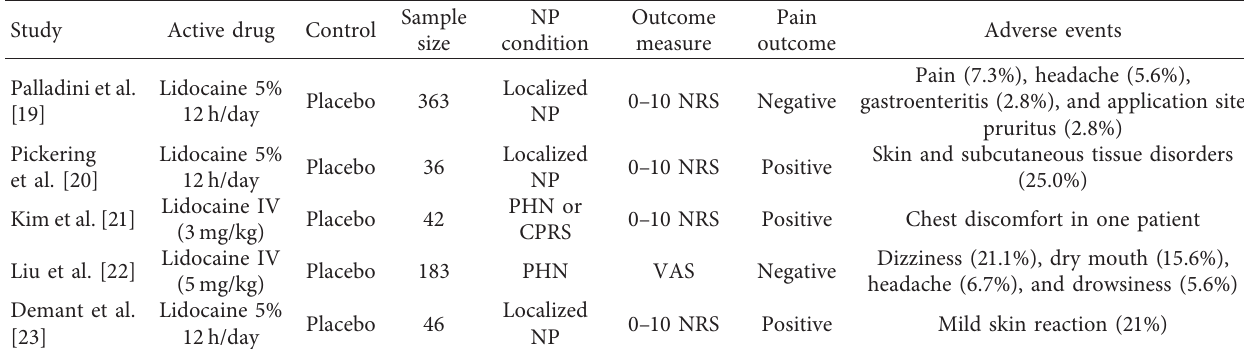
Table 3: Randomized, double-blind, controlled trials testing the effect of lidocaine.